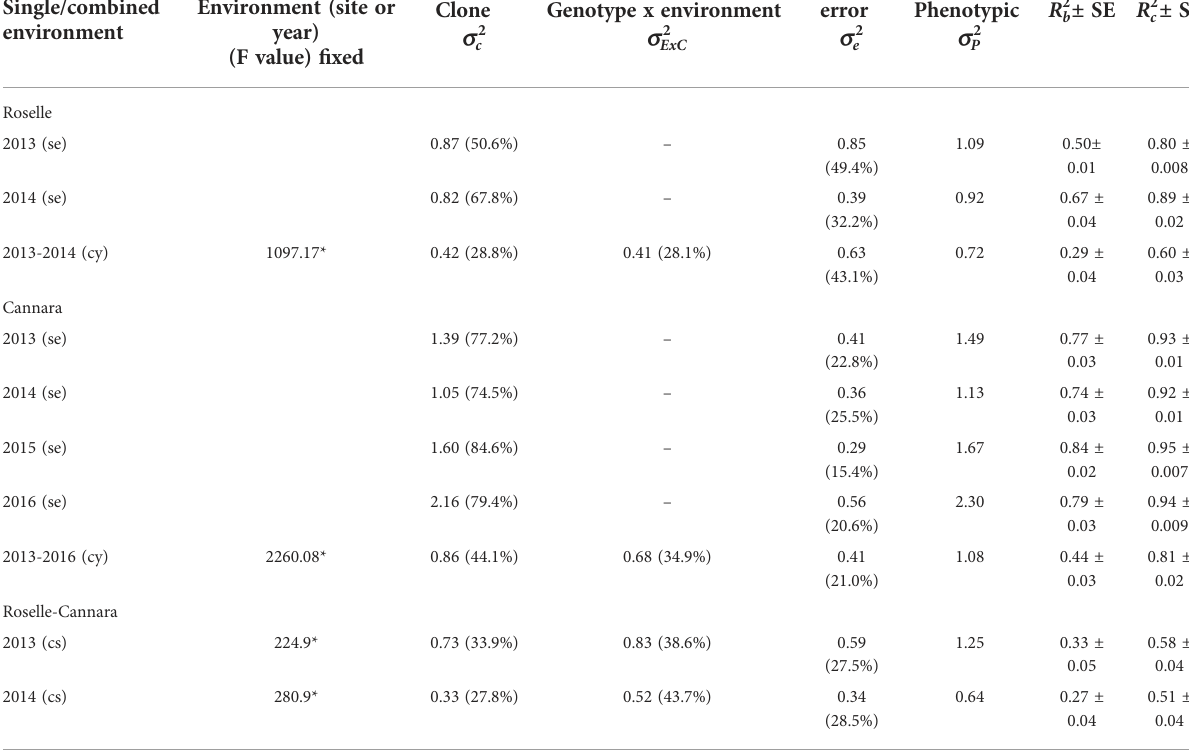
TABLE 2 ANOVA variance component analysis of male cone production of C. sempervirens clones.